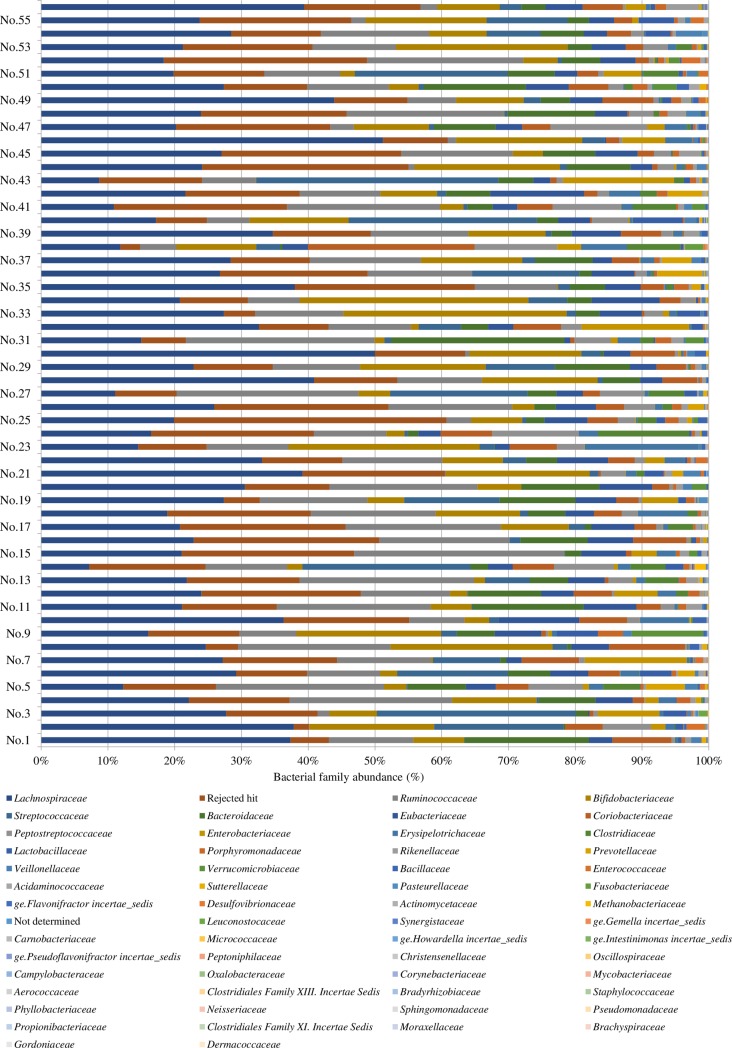
Fecal microbiota composition at the family level in samples from elderly Japanese subjects.Columns are color-coded according to bacterial families. The X axis shows the bacterial family abundance (%). The Y axis shows the volunteer number.